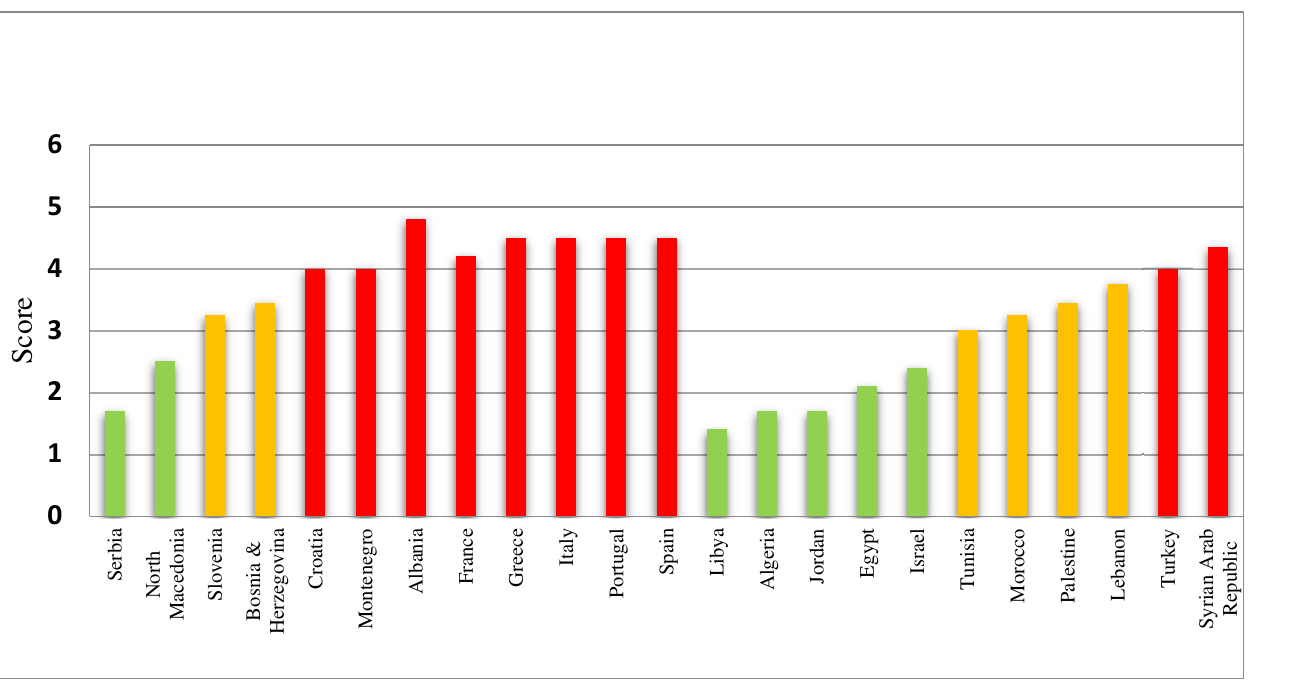
Figure 1. Risk scores of the European Balkans, European Mediterranean, and MENA countries according to six establishments and spread risk indicators. Green, yellow and red colours refer to low, medium, and high risk scores, respectively.